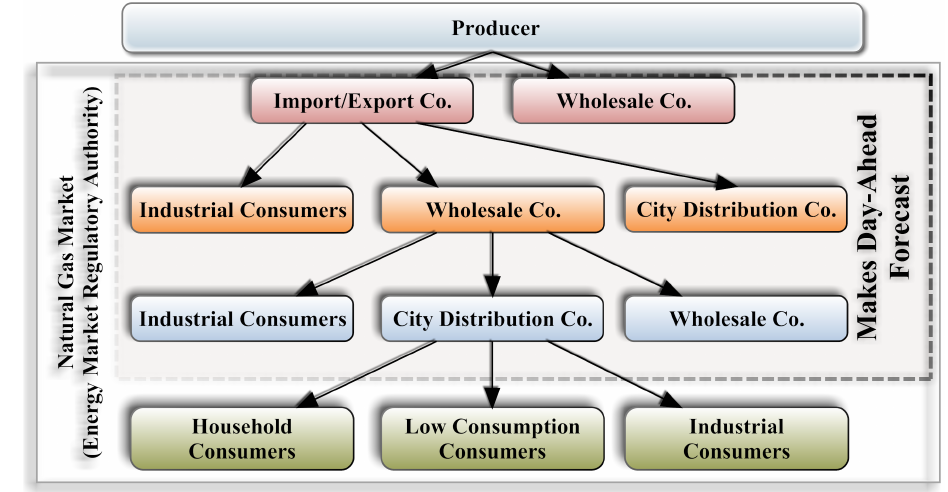
Figure 1. Turkey natural gas market and